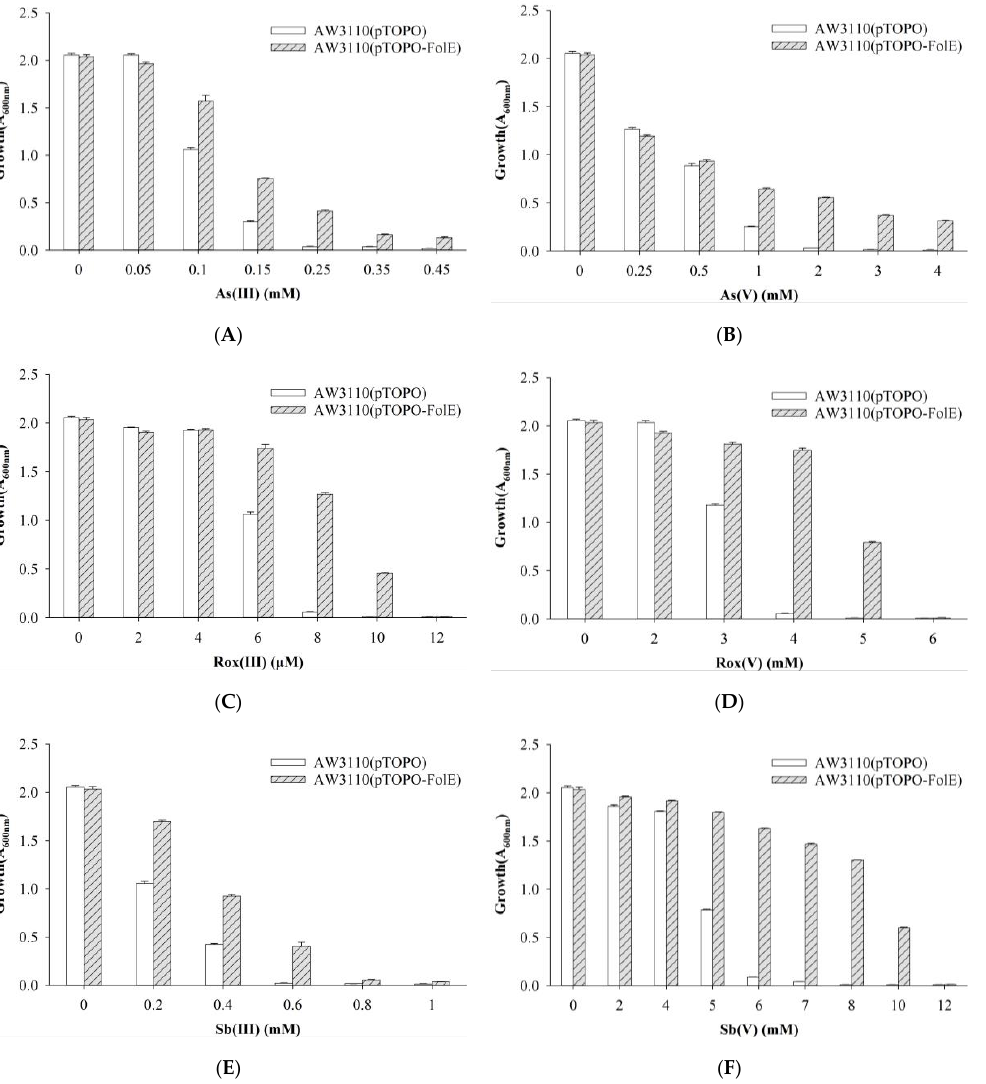
Figure 3. Growth of E. coli AW3110 bearing pTOPO and pTOPO-FolE with the indicated concentra- tions of As(III) ( A ), As(V) ( B ), Rox(III) ( C ), Rox(V) ( D ), Sb(III) ( E ), and Sb(V) ( F ). The A 600nm was measured after 24 h of growth at 37 °C and 220 rpm. The graphs show the results of three replicates, and error bars represent the standard error of the average values. To investigate the function of the acr3- and arsH -encoded gene products also present in the ars 2 operon, acr3 and arsH from strain Au-Bre30 were cloned into the pTOPO plas- mid. The arsenic-sensitive strain E. coli AW3110 carrying plasmid pTOPO-Acr3 was able to grow in 1.2 mM, 8 μM, 0.8 mM , and 10 mM of As(III), Rox(III), Sb(III), and Sb(V), re- spectively, while the strain containing the empty pTOPO did not grow under the same conditions. However, E. coli AW3110 carrying plasmid pTOPO-Acr3 or pTOPO did not display significant differences when exposed to As(V) and Rox(V). Expression of acr3 con- ferred very significant resistance to As(III), Sb(III), and Sb(V), conferred a small increase in resistance to Rox(III), but did not confer resistance to As(V) and Rox(V) (Figure 4). E. coli AW3110 carrying plasmid pTOPO- ArsH was able to grow in 0.45 mM, 8 μM, 3 mM, 2 mM, and 7 mM of As(III), Rox(III), Sb(III), As(V), and Sb(V), respectively, while E. coli